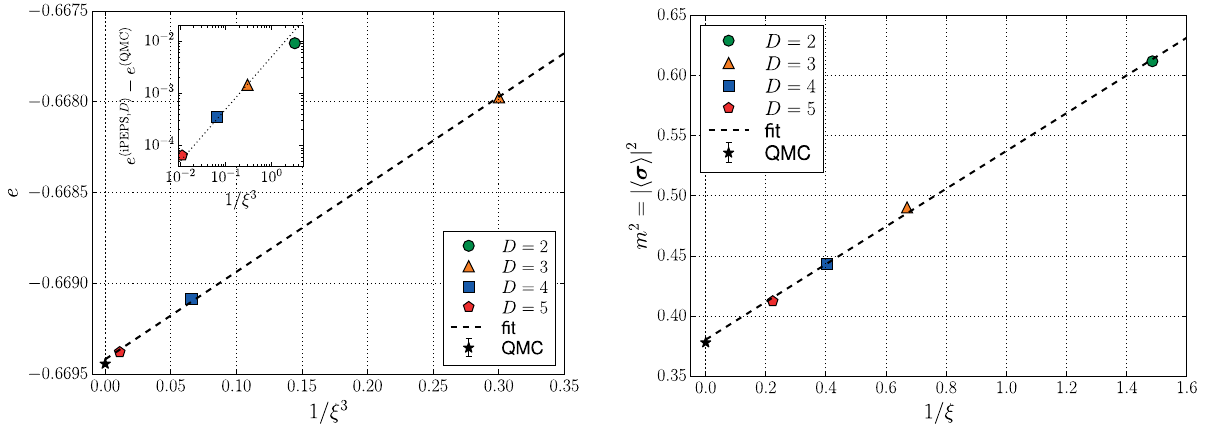
FIG. 6. S ¼ 1 = 2 Heisenberg antiferromagnet: iPEPS data for the ground-state energy per site e (left-hand panel) and the order parameter squared m 2 (right-hand panel). We plot the data as a function of the expected 1 = ξ 3 (for e ) and 1 = ξ (for m 2 ) dependence. The linear fits to the D ¼ 3 , 4, 5 results in the left-hand and all D ≥ 2 in the right-hand panel extrapolate closely to the high-precision quantum Monte Carlo reference results [56]. The inset in the left-hand panel highlights the overall 1 = ξ 3 convergence of the energy per